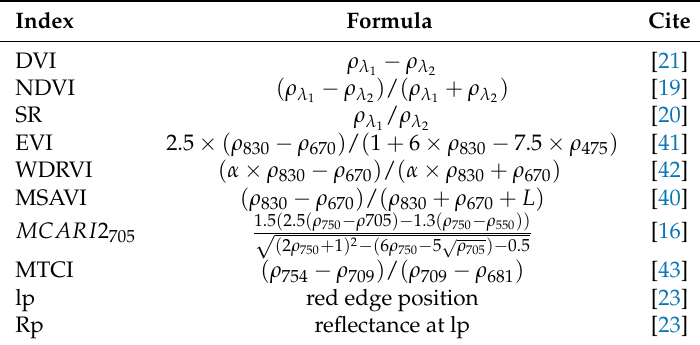
Table 2. Vegetation indices evaluated in this